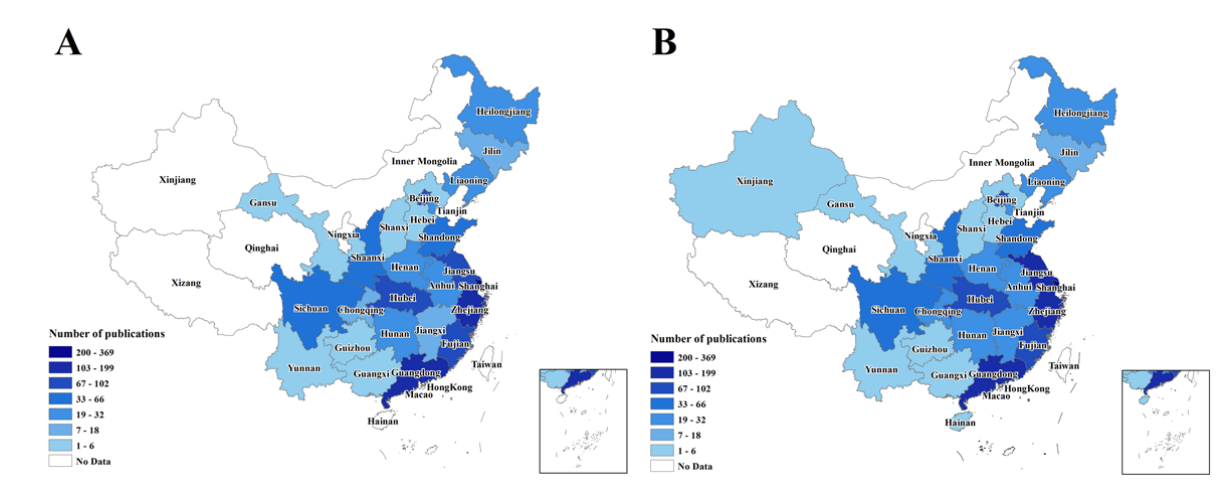
Figure 4. The distribution of the publications stratified by first authors (A) and corresponding authors (B) using the Surveillance, Epidemiology, and End Results database.